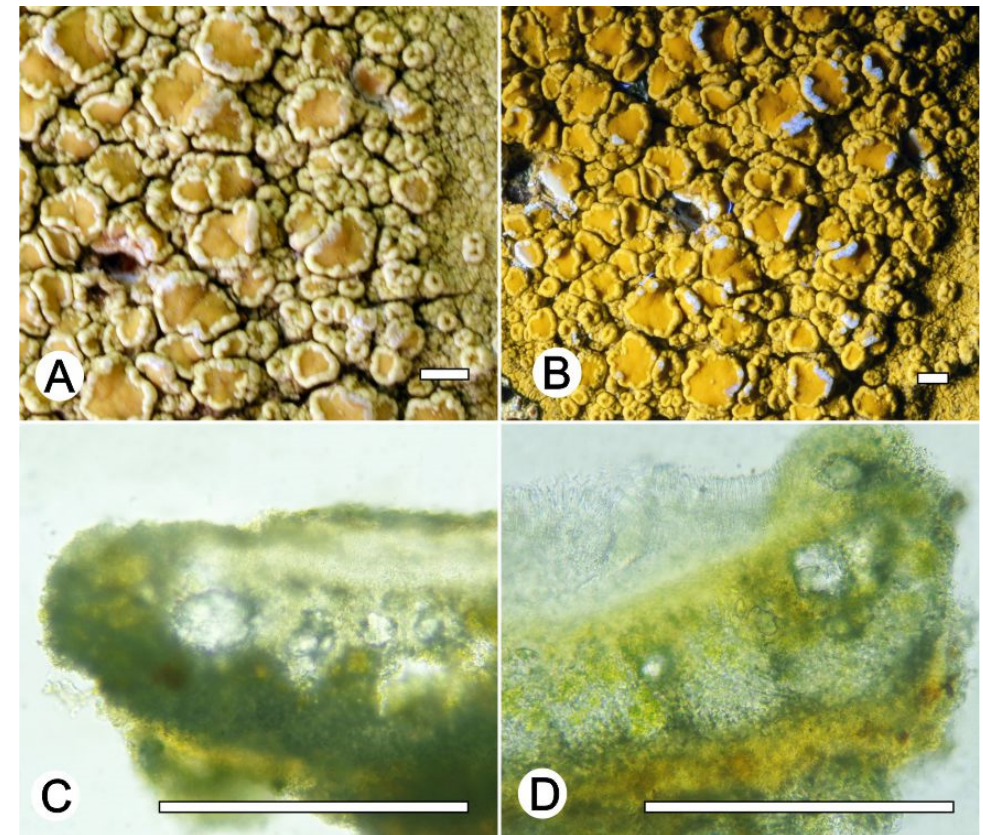
Figure 11. Lecanora parahelva sp. nov. ( A ) Thallus with ascomata (holotype ISE-54323); ( B ) Medulla UV+ greenish white (holotype ISE-54323); ( C ) Apothecial section in water (holotype ISE-54323); ( D ) Apothecial section after KOH treatment (holotype ISE-54323). Scale bars: ( A,B ), 1 mm; ( C , D ), 100 µm.